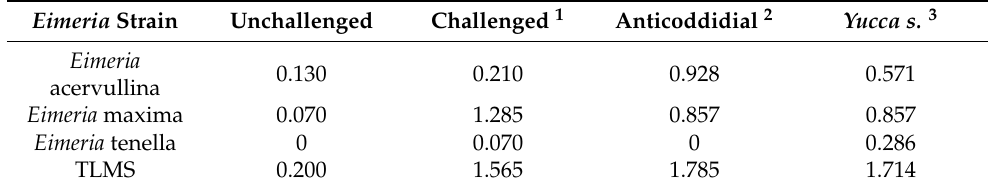
Table 5. Lesion scores of unchallenged and challenged chickens at 28 days of